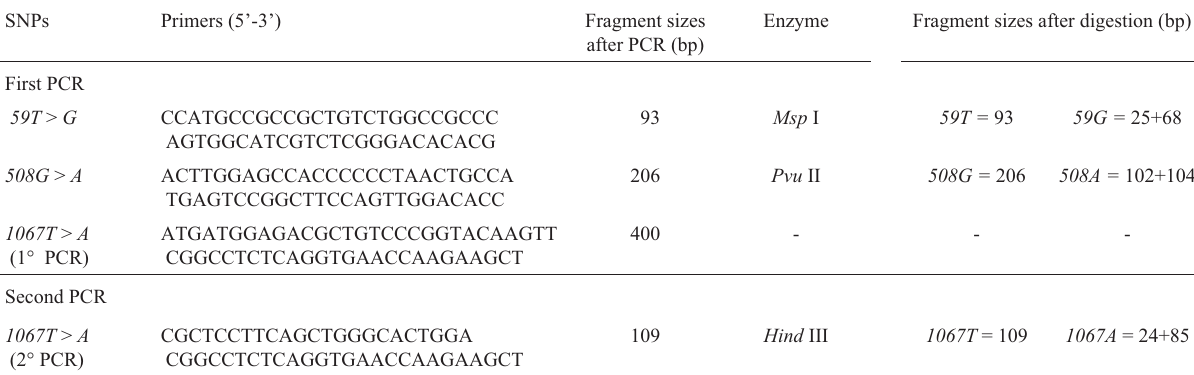
Table 1 - FUT3 gene single nucleotide polymorphism (SNP), PCR primer sequences and fragment sizes in base pairs (bp) before and after digestion by each restriction enzyme. The 1067T > A SNP was treated with restriction enzyme only after the second PCR.